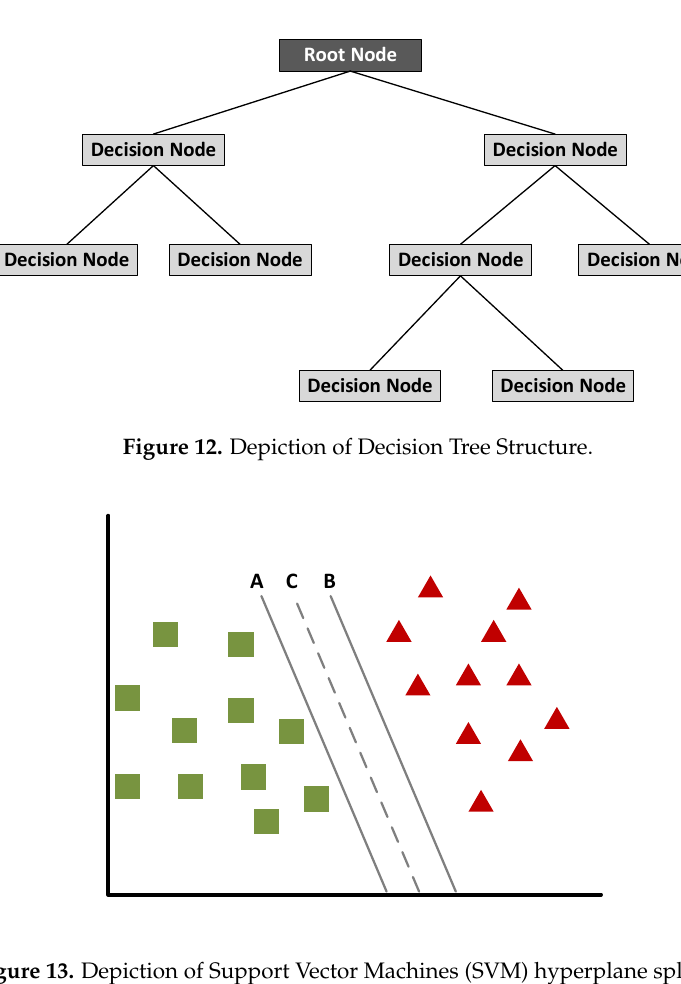
Figure 13. Depiction of Support Vector Machines (SVM) hyperplane